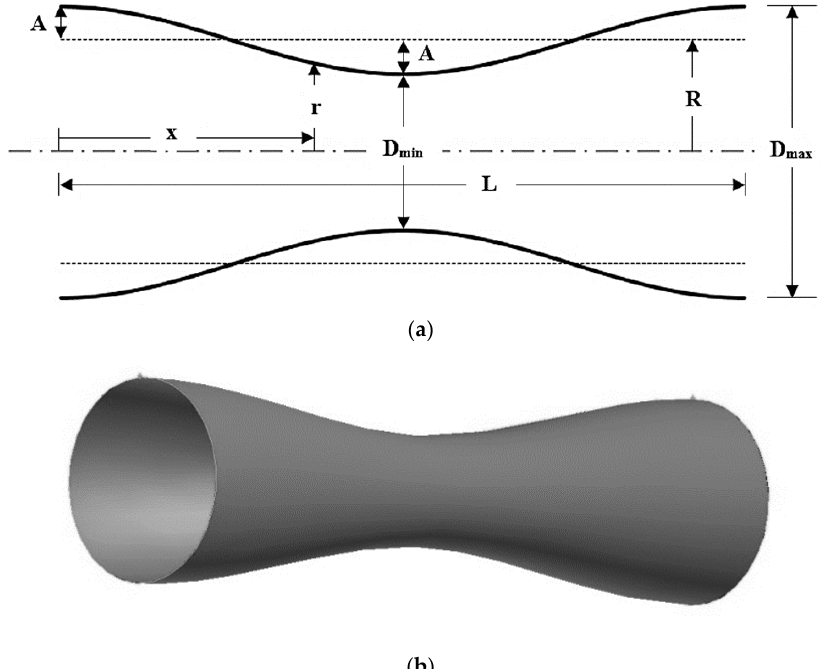
Figure 1. ( a ) Geometric variables of the wavy-walled tube and ( b ) physical view of a single period of the wavy-walled tube.